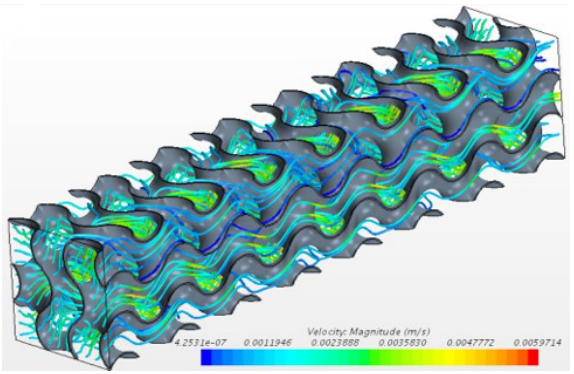
Figure 4. Streamlines obtained for the case Re =